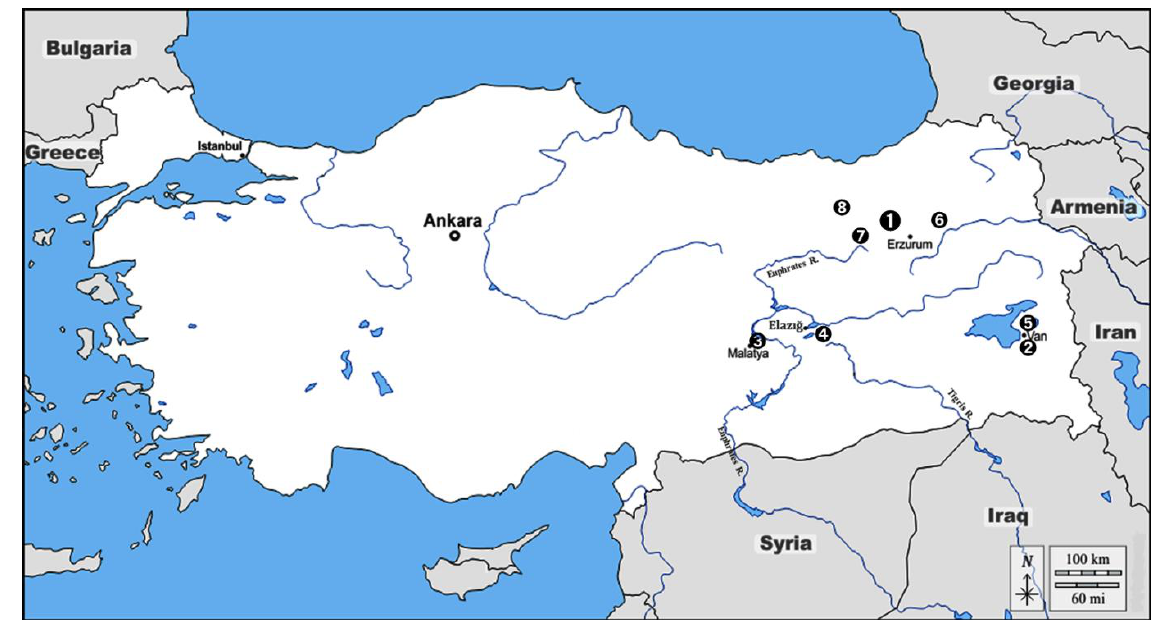
Figure 1. Location of the Eastern Anatolian Bronze Age-Iron Age sites mentioned in the text: 1. Alaybeyi Hoyuk; 2. Yoncatepe; 3. Arslantepe; 4. Iron Age sites under Keban Project; 5. Altıntepe; 6. Sos Höyük; 7. Büyükardiç; and 8. Büyüktepe Höyük (map by A.B. Siddiq).